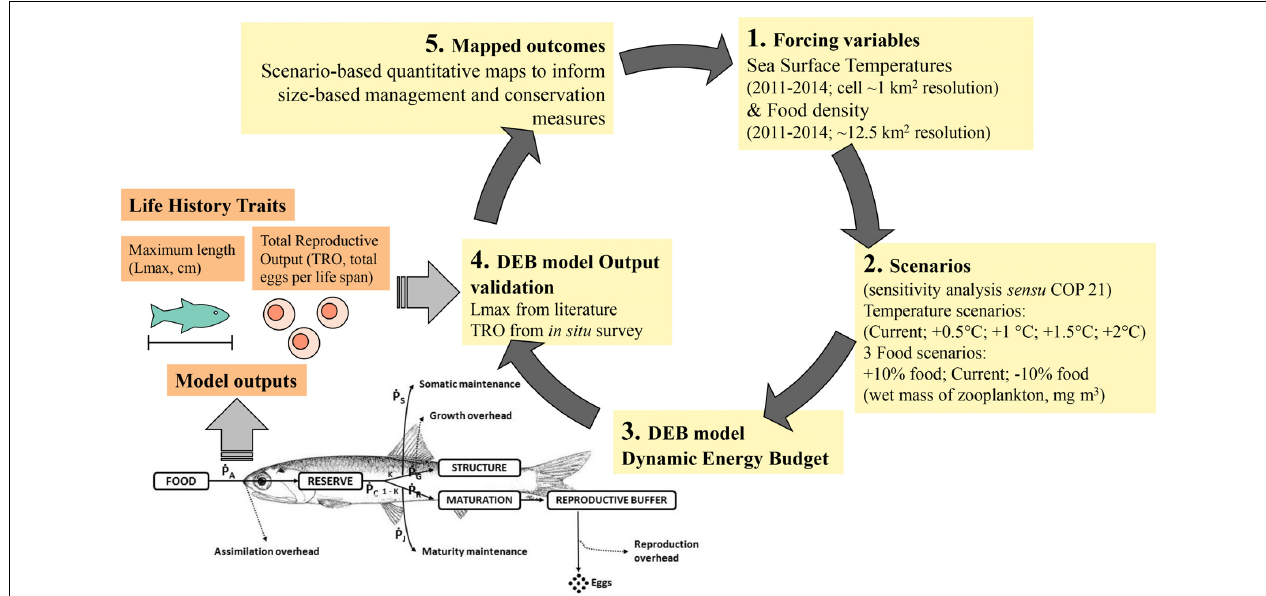
FIGURE 1 | Rationale of the